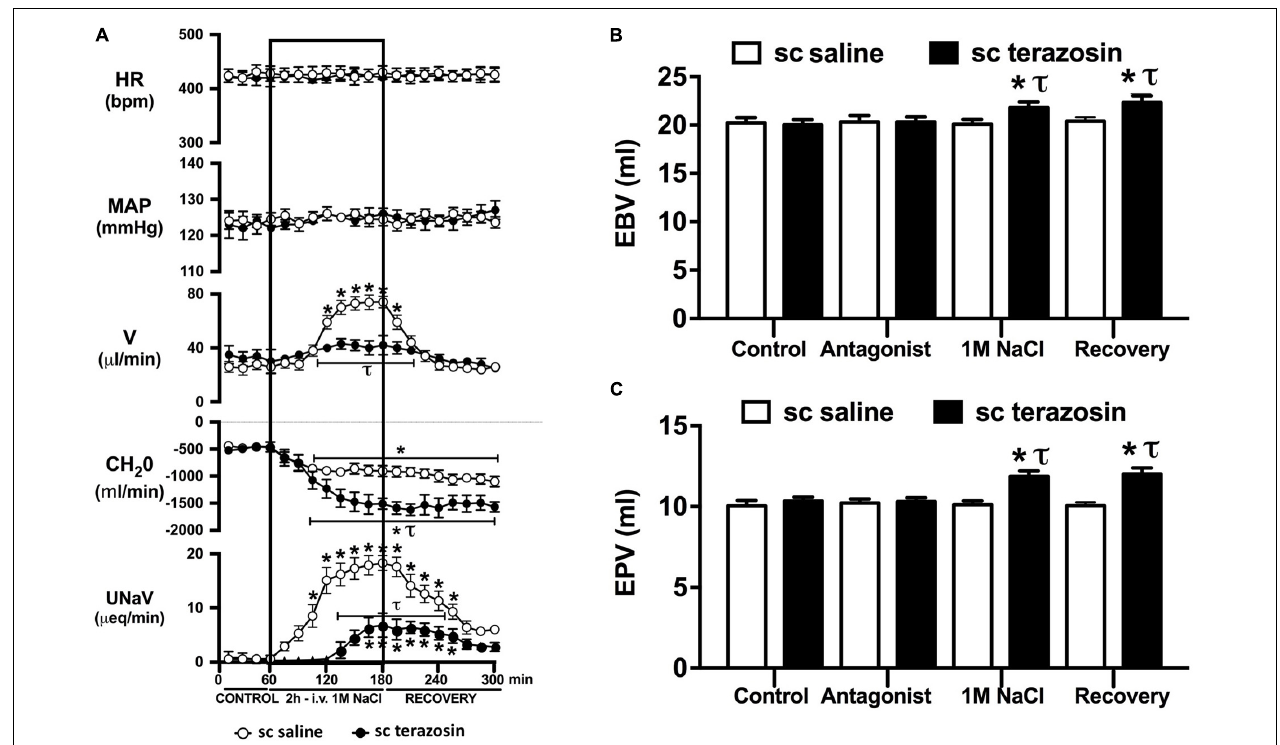
FIGURE 6 | Effect of chronic s.c. terazosin-mediated α 1 -adrenoceptor antagonism on the cardiovascular and renal responses to an acute 1M NaCl infusion (A) Cardiovascular and renal responses, (B) Estimated blood volume (ml), and (C) Estimated plasma volume (ml) during a 1-h control isotonic saline infusion (20 µ l/min), a 2-h 1M NaCl infusion (20 µ l/min) and a 2-h recovery period of isotonic saline infusion (20 µ l/min) in intact conscious male Sprague Dawley rats receiving a s.c. saline/DMSO vehicle or s.c. terazosin (10 mg/kg/day) infusion. HR = heart rate (bpm), MAP = mean arterial pressure (mmHg), V = urinary flow rate ( µ L/min), CH 2 O = free water clearance, UNaV = urinary sodium excretion ( µ eq/min). Data are presented as mean ± SEM, N = 6/group. * p < 0.05 vs. group baseline value in last 15-min of the control saline infusion. τ p < 0.05 vs. respective sc saline/DMOS group infusion